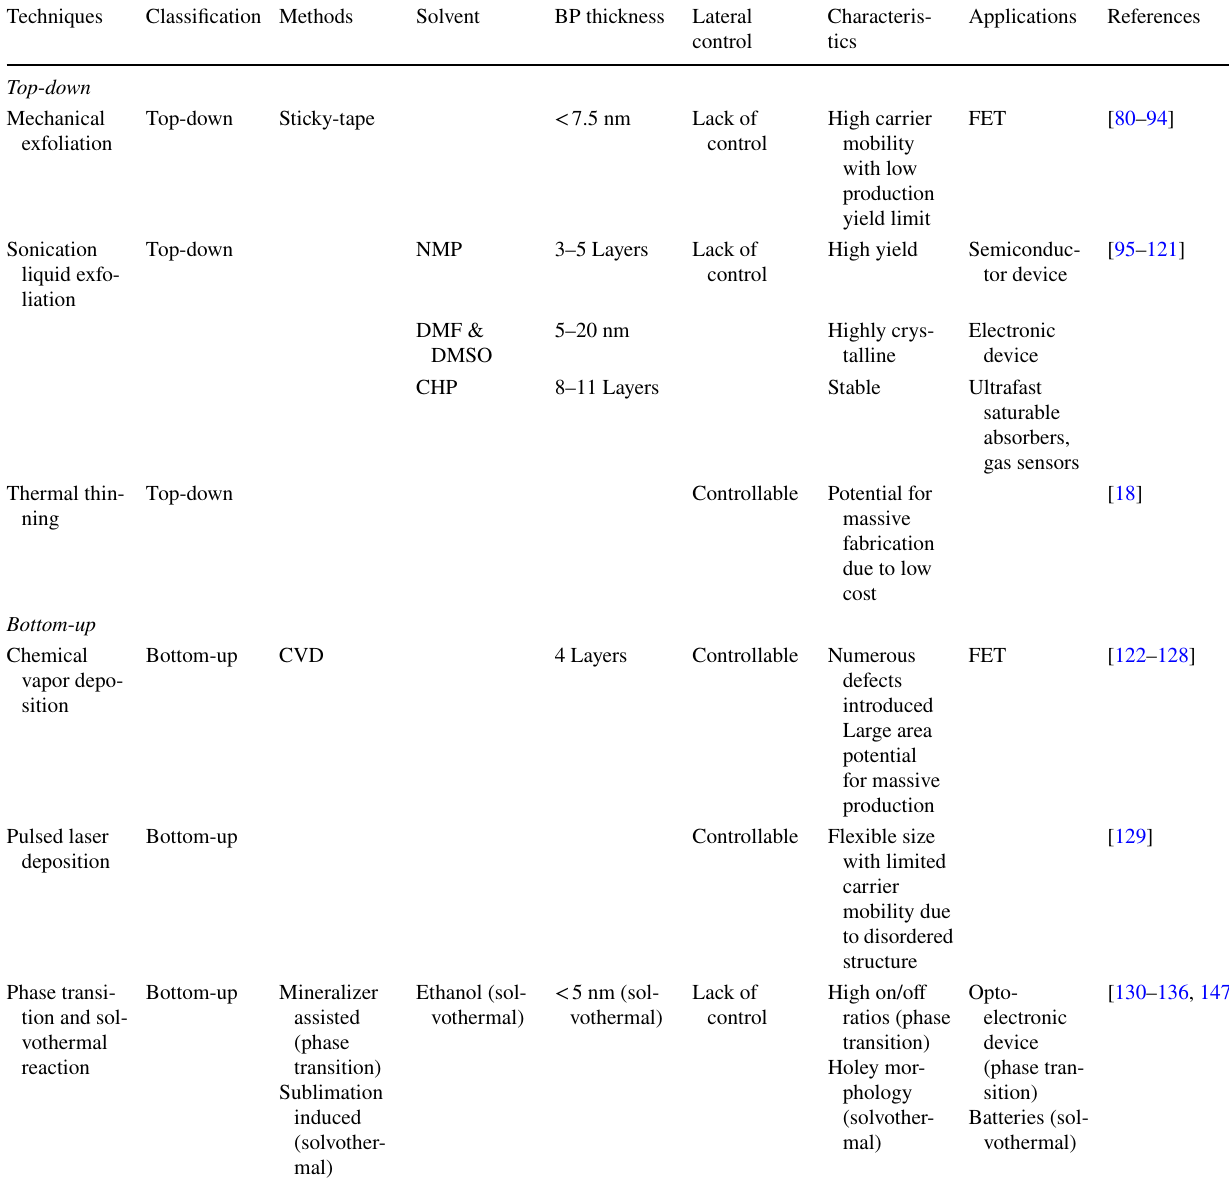
Table 2 Summary of the comparison on the different preparation method and process, thickness, characteristics, and application of few-layer BP